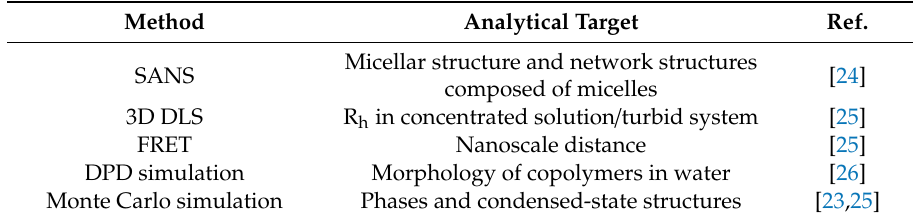
Table 2. Methods of structural analysis of thermoresponsive